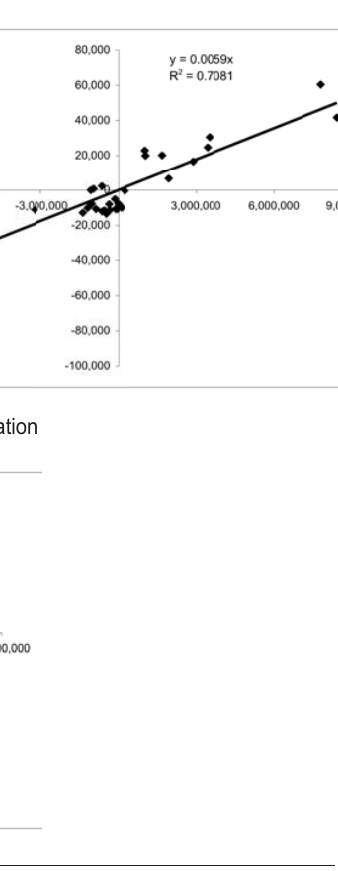
Figure 4: Total project energy v cost residual correlation Figure 5: Embodied energy v capital cost residual correlation